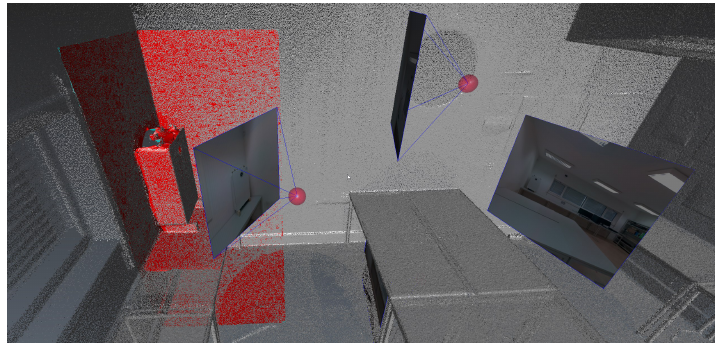
Figure 2. Two viewpoints from the dataset. The gray points represent the point cloud, the red surface represents the 3D mesh, and the red spheres represent the scan locations. The images are also shown, with frustum in